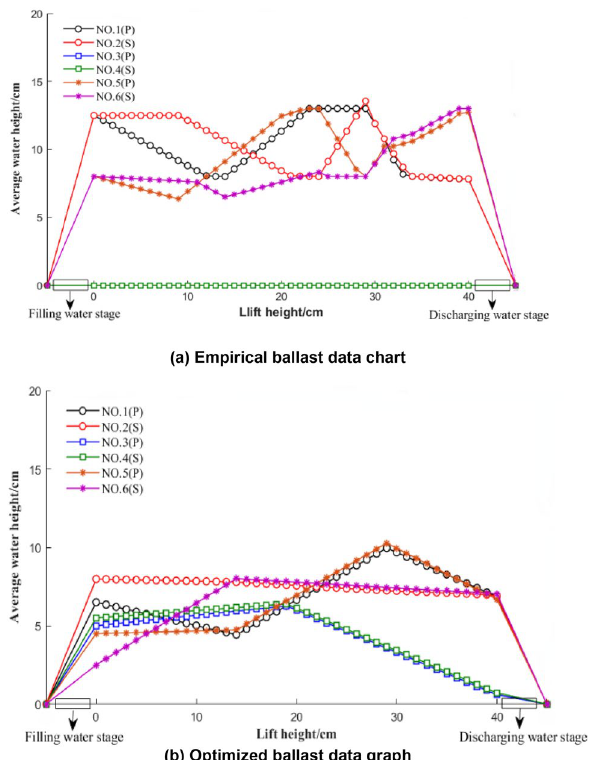
Figure 12. Change chart of the average water level of each ballast tank under experience and optimization schemes.